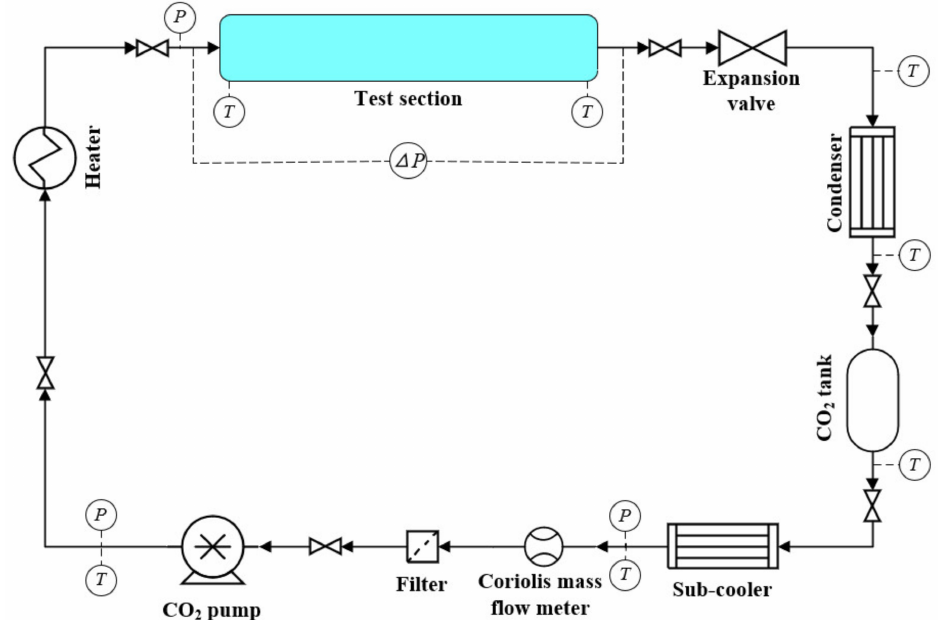
Figure 5. Schematic diagram of a typical SCO 2 cooling and heat transfer experimental